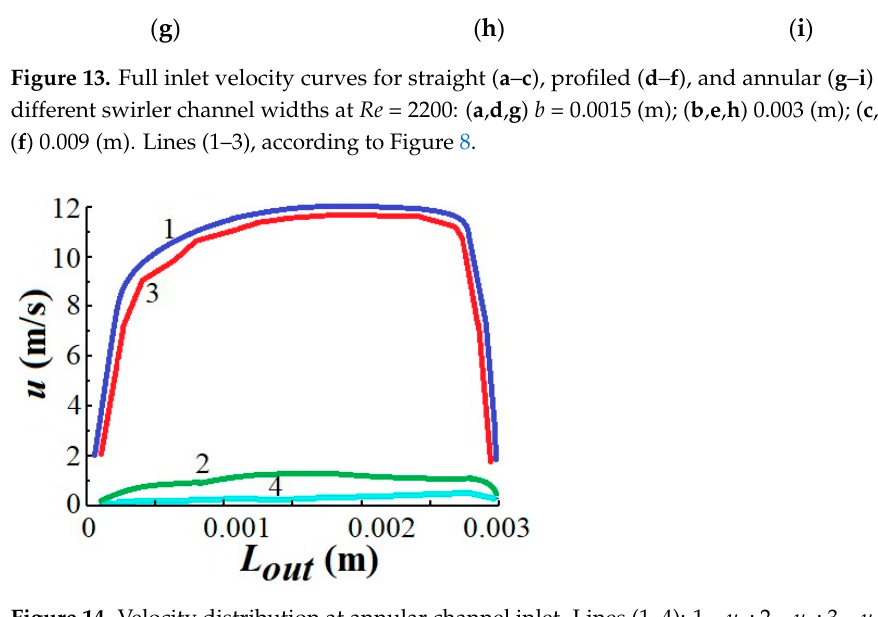
Figure 14. Velocity distribution at annular channel inlet. Lines (1–4): 1— u p ; 2— u x ; 3— u y ; 4— u z . The tangential velocity u y distribution curves in the annular channel, computed for different channel lengths, are presented in Figure 15. According to the collected data, the tangential velocity element increases along the annular channel length under 0.007 (m). For this reason, designing a further increase in the swirler channel length is not Compared to the straight channel walls, the tangential velocity component for the annular channels dominates the others.